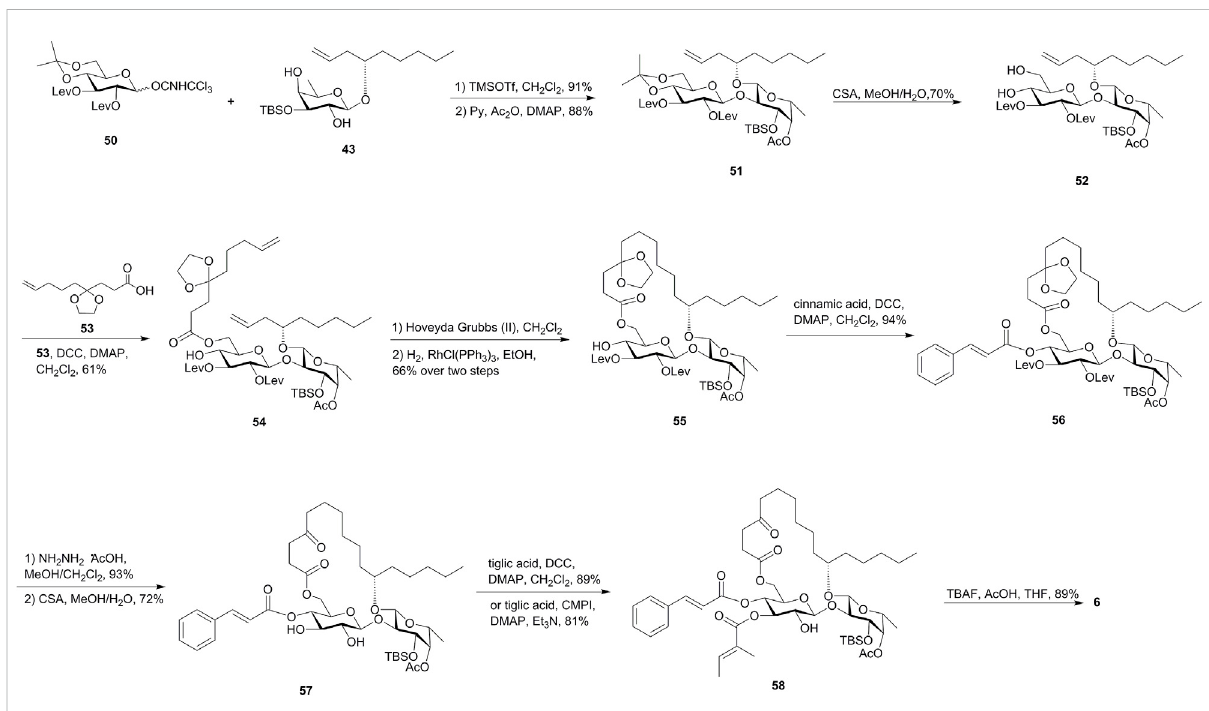
FIGURE 6 Second Shi ’ s approach toward the synthesis of ipomoeassin F ( 6 ). Lev, levulinoyl; CSA, camphor-10-sulfonic acid; CMPI, 2-chloro-1- methylpyridinium